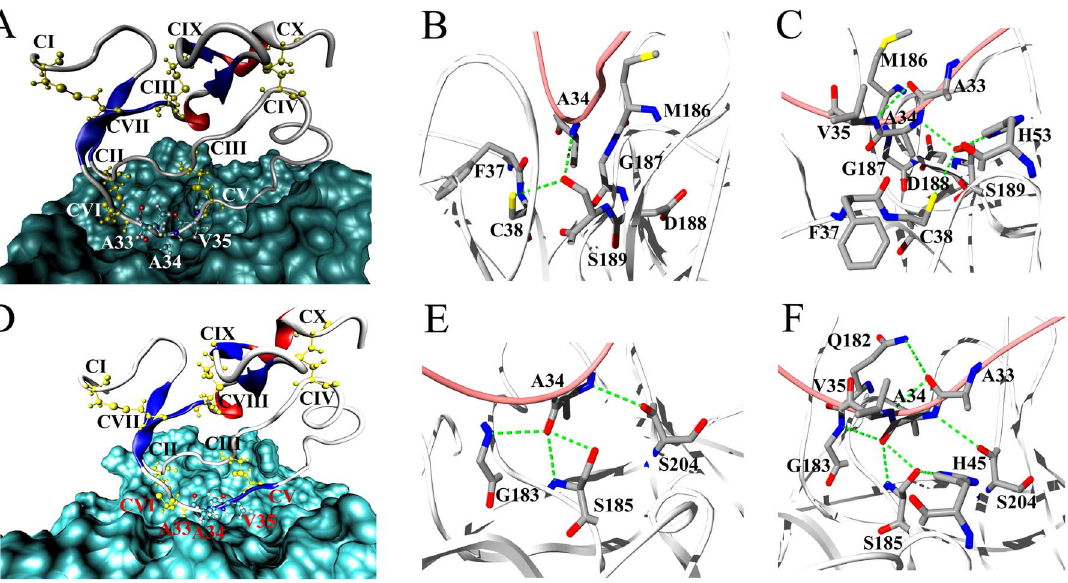
Figure 6. Molecular simulation of SjAPI interacting with chymotrypsin and elastase. (A) The SjAPI-chymotrypsin complex predicted by MD simulation. (B) Ala34, the P1 site of SjAPI, fits into the pocket of chymotrypsin. (C) Residues of chymotrypsin interacting with Ala33, Ala34 and Val35 residues, the P1 9 , P1 and P2 sites of SjAPI. (D) The SjAPI-elastase complex predicted by MD simulation. (E) Ala34, the P1 site of SjAPI, fits into the pocket of elastase. (F) Residues of elastase interacting with Ala33, Ala34 and Val35 residues, the P1 9 , P1 and P2 sites of SjAPI. doi:10.1371/journal.pone.0057529.g006 chymotrypsin- and elastase-inhibiting properties, but had no effect on trypsin (Fig. 4). The inhibitory constant (Ki) was further determined by Lineweaver-Burk plots and subsequent slope replotting. rSjAPI inhibited a -chymotrypsin and elastase with Ki values of 97.1 6 6.5 nM and 3.7 6 0.4 m M, respectively (Fig. 5 and